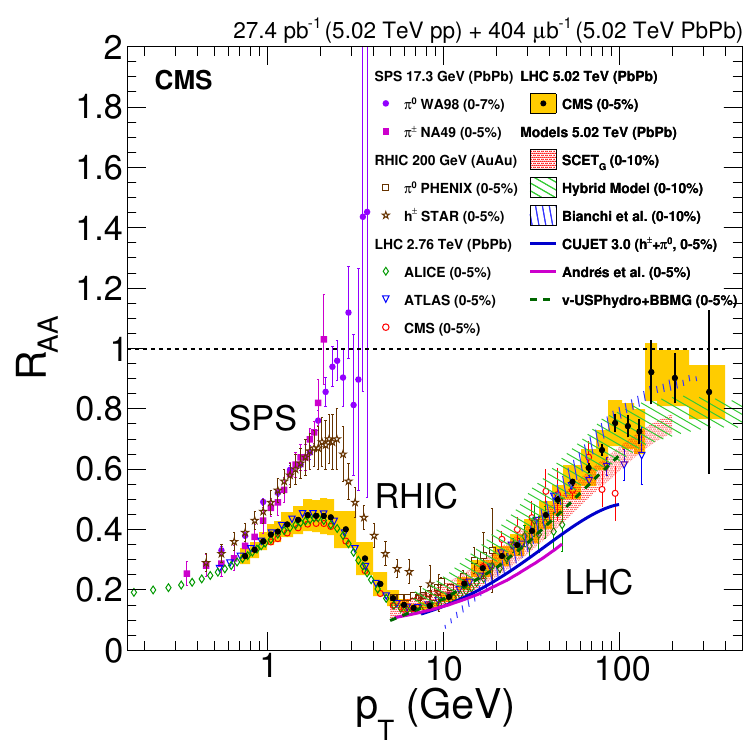
Figure 5 . Measurements of the nuclear modi(cid:12)cation factors in central heavy-ion collisions at four di(cid:11)erent center-of-mass energies, for neutral pions (SPS, RHIC), charged hadrons ( h (cid:6) ) (SPS, RHIC), and charged particles (LHC), from refs. [3, 4, 9{11, 50{52], compared to predictions of six p models for s NN = 5 : 02 TeV PbPb collisions from refs. [38{43]. The error bars represent the sta- tistical uncertainties. The yellow band around the 5.02 TeV CMS data points show the systematic uncertainties of this measurement, including that of the integrated luminosity. The T AA uncertain- ties, of the order of (cid:6) 5%, are not shown. Percentage values in parentheses indicate centrality ranges. interpolated pp reference spectrum [13]. At the p value of the largest deviation, 65 GeV, T R is 1 : 19 (cid:6) 0 : 02 (stat) +0 : 13 (syst), while R (cid:3) is 1 : 41 (cid:6) 0 : 01 (stat) +0 : 20 (syst). The R pA (cid:0) 0 : 11 (cid:0) 0 : 19 pA